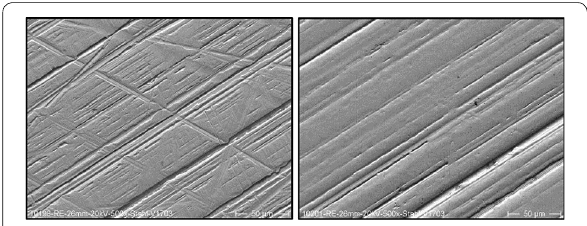
Figure 4 Surface pictures (SEM) of steel plates—new condition (left) and run-in state (right)